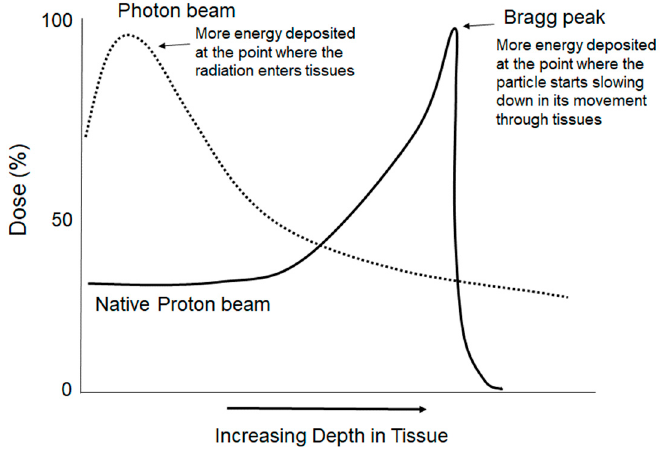
Figure 2. Schematic of the Bragg peak. As radiation energy traverses tissue, it distributes energy. A low-energy photon beam deposits a greater amount of energy at shallow tissue depths (dotted line).